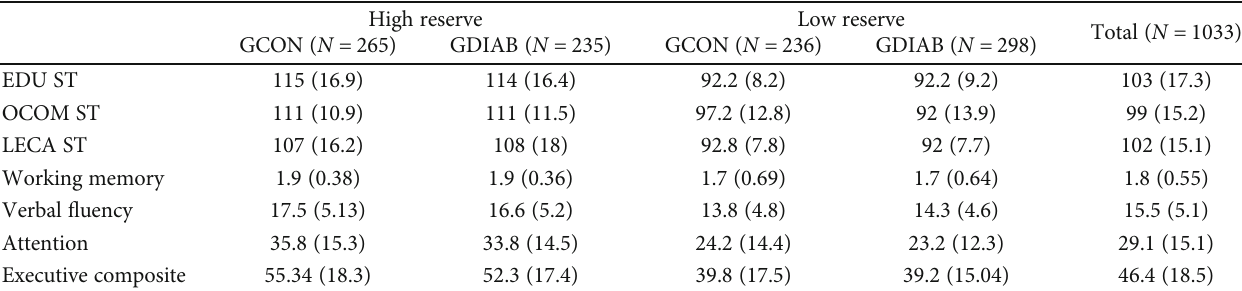
Table 2: Group comparisons on cognitive reserve proxies and executive function performance.